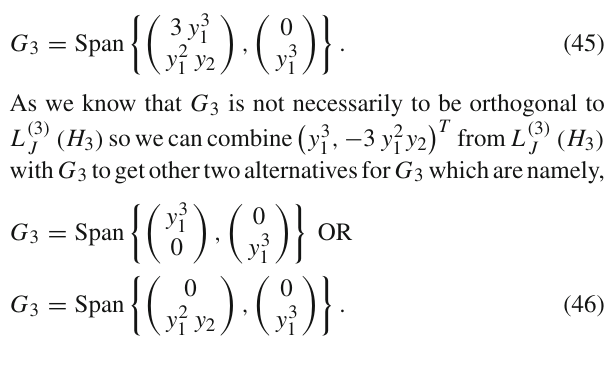
sphere of the Poincaré sphere which is difficult to draw. In contrast, the orthogonal projection of the upper hemisphere of the Poincaré sphere on the unit disk in the ( X , Y ) plane